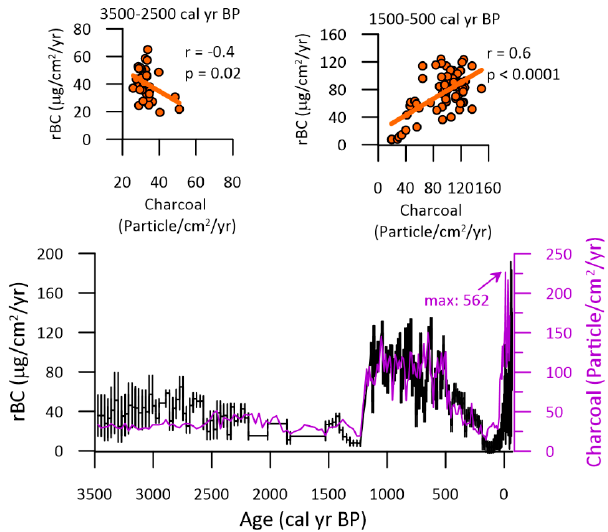
Figure 3. Comparison of macrocharcoal influx (purple) [41,42] and refractory black carbon (rBC) influx (black) from Lake Caranã. Insets show the correlation between macrocharcoal and rBC from 3500 to 2500 cal yr BP ( upper left ) and 1500 to 500 cal yr BP ( upper right ).